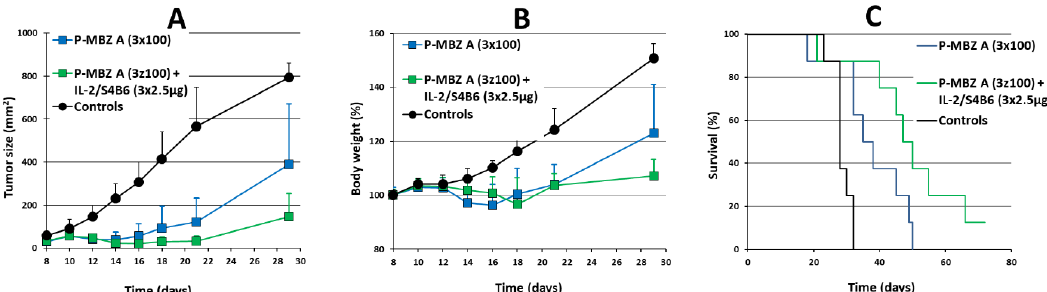
Figure 8. Potentiation of antitumour activity of polymer-bound mebendazole conjugate through IL-2 immunocomplexes in vivo. B6 mice ( n = 8) were s.c. inoculated with 10 5 EL-4 cells on day 0, then i.p. injected with 3 doses (100 mg mebendazole/kg per one dose) of HPMA copolymer-bound mebendazole conjugate ( P-MBZ-A (3 × 100)) on days 8, 10, and 12, or with the latter plus complexes of IL-2 and anti-IL-2 mAb S4B6 mAb (2.5 µg IL-2 per one dose) on days 14, 16, and 18 ( P-MBZ-A (3 × 100) + IL-2co). Untreated mice were used as controls. Tumour growth ( A ), body weight ( B ), and survival ( C ) were monitored, and each experimental point ( A , B ) is the average of the experimental group ±